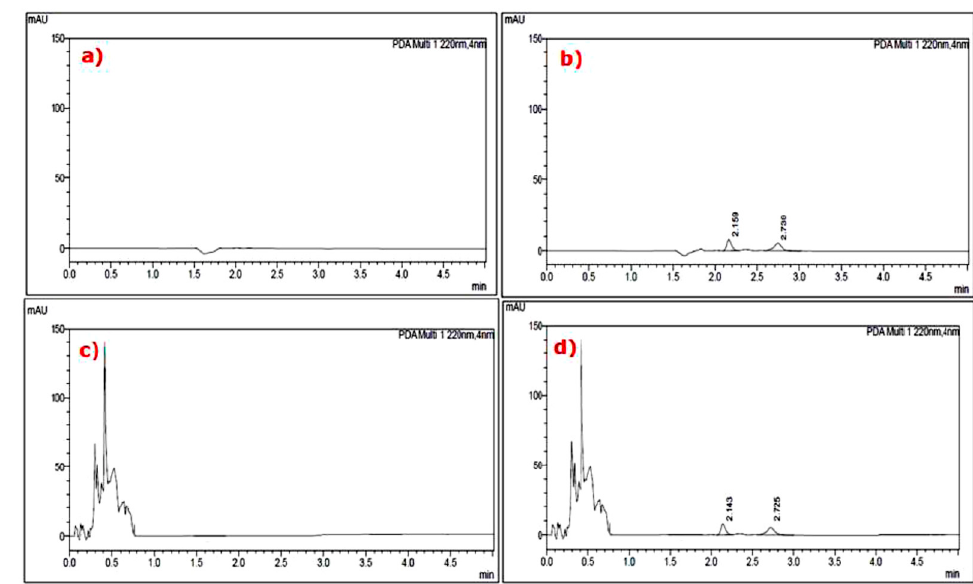
BDL—Below the detectable level.